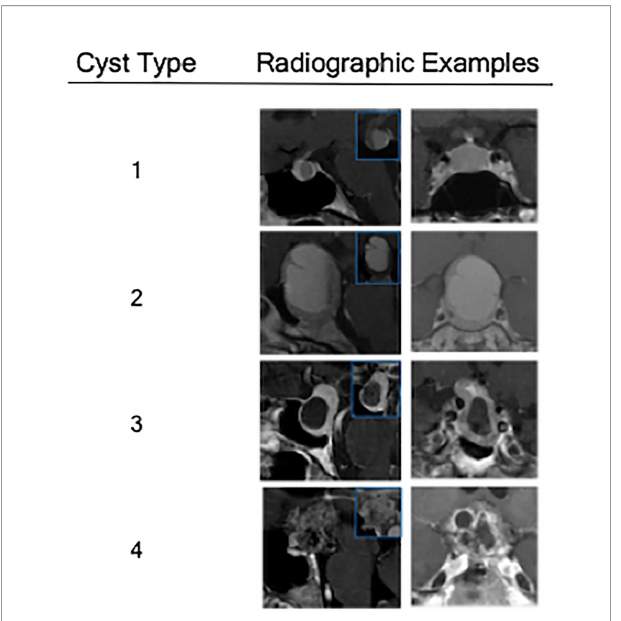
FIGURE 2 | Radiographic examples of each class of cystic sellar masses, with illustrative sagittal post-contrast T1-weighted MRI (left), sagittal pre- contrast T1-weighted MRI (small box), and coronal post-contrast T1-weighted MRI (right).